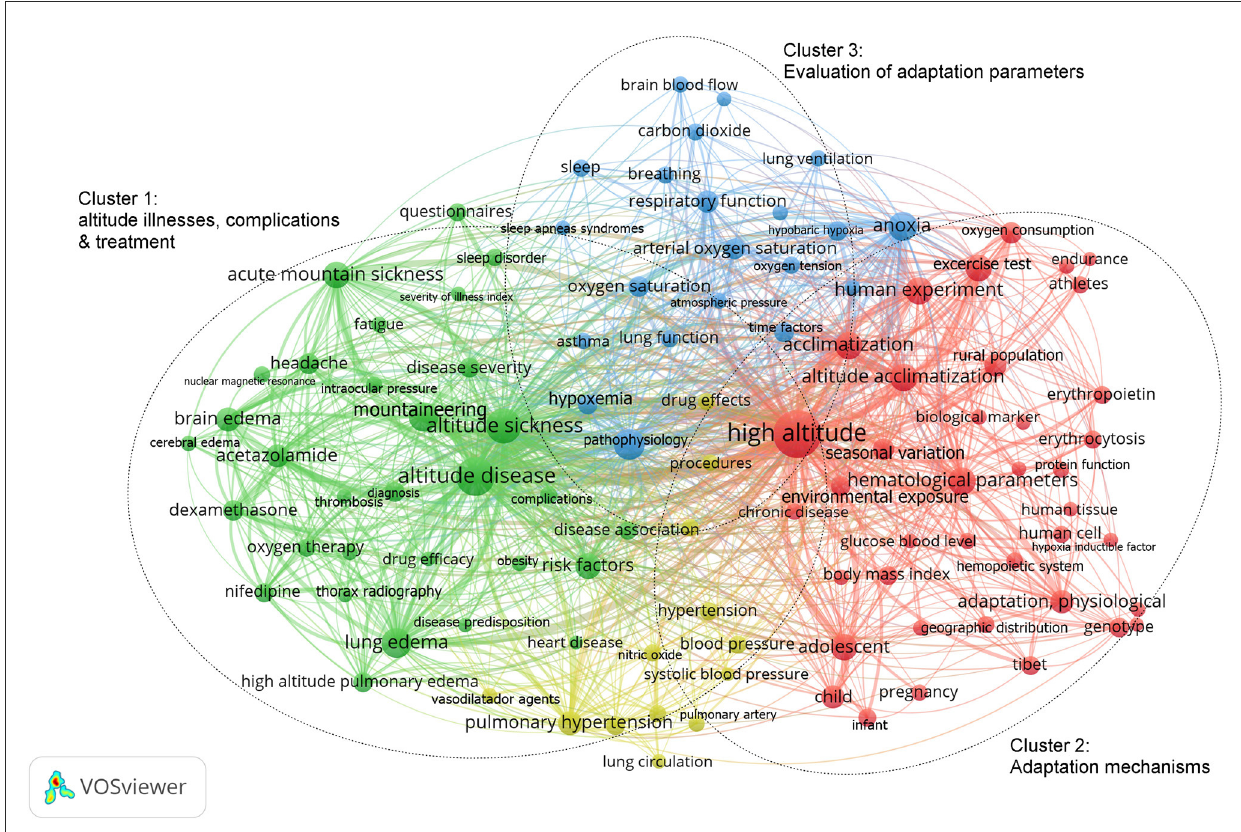
FIGURE4 Network of occurrences of the map of keywords in adaptation and altitude illnesses.